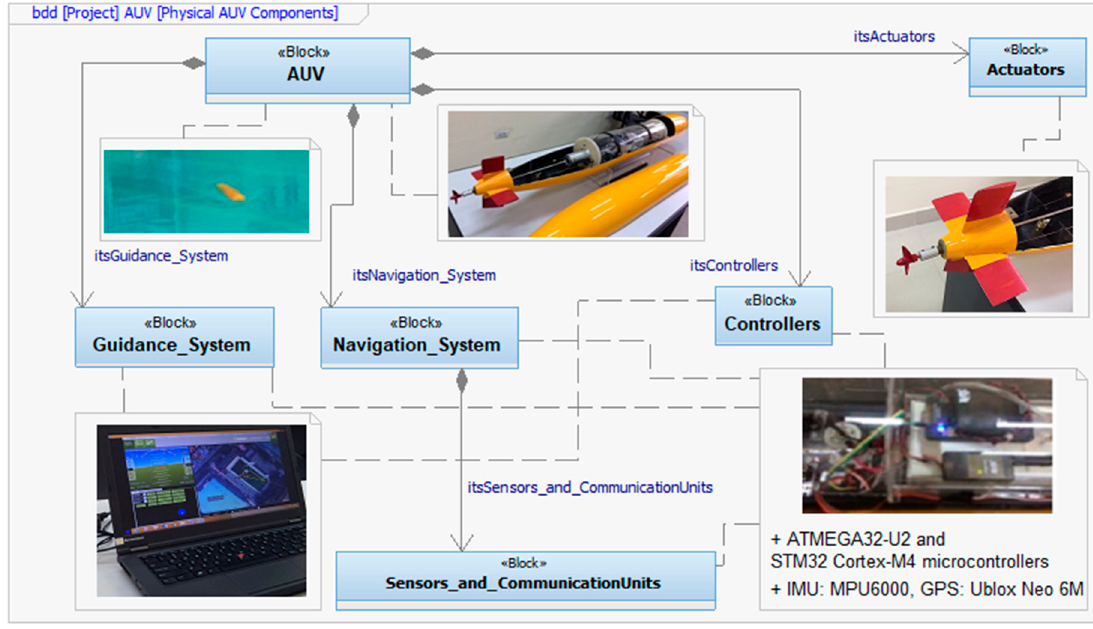
Figure 9. AUV installation for trial trips. Table 4. Testing results for the course-tracking of the torpedo-shaped AUV.